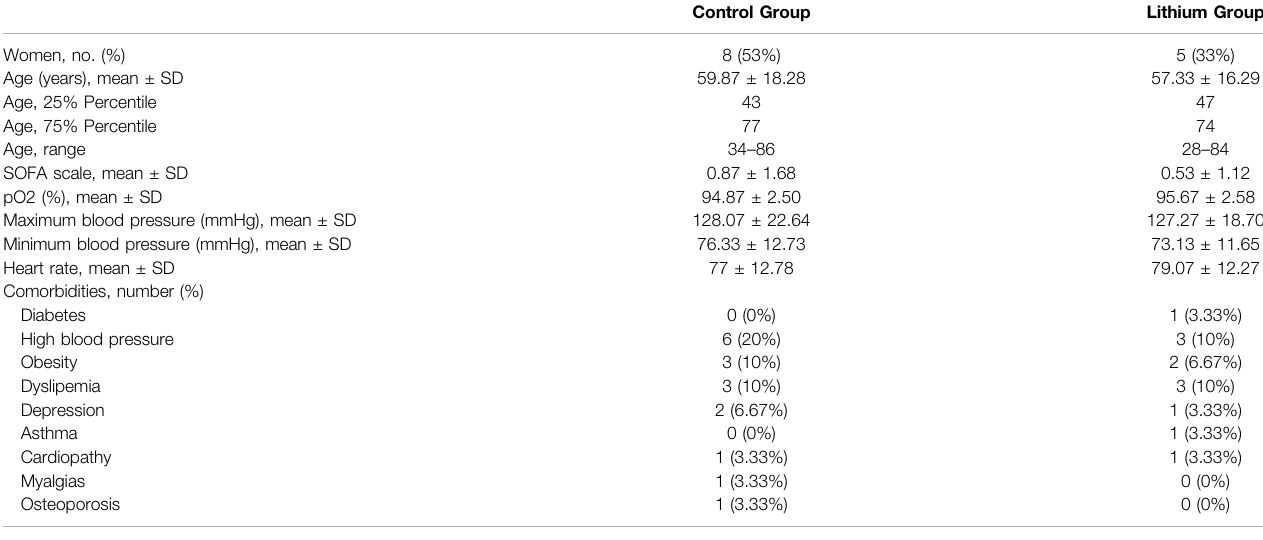
Control Group Lithium Group